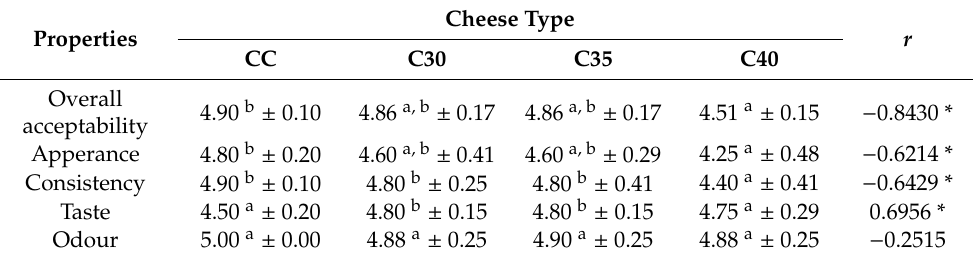
Table 5. Organoleptic evaluation of acid-curd